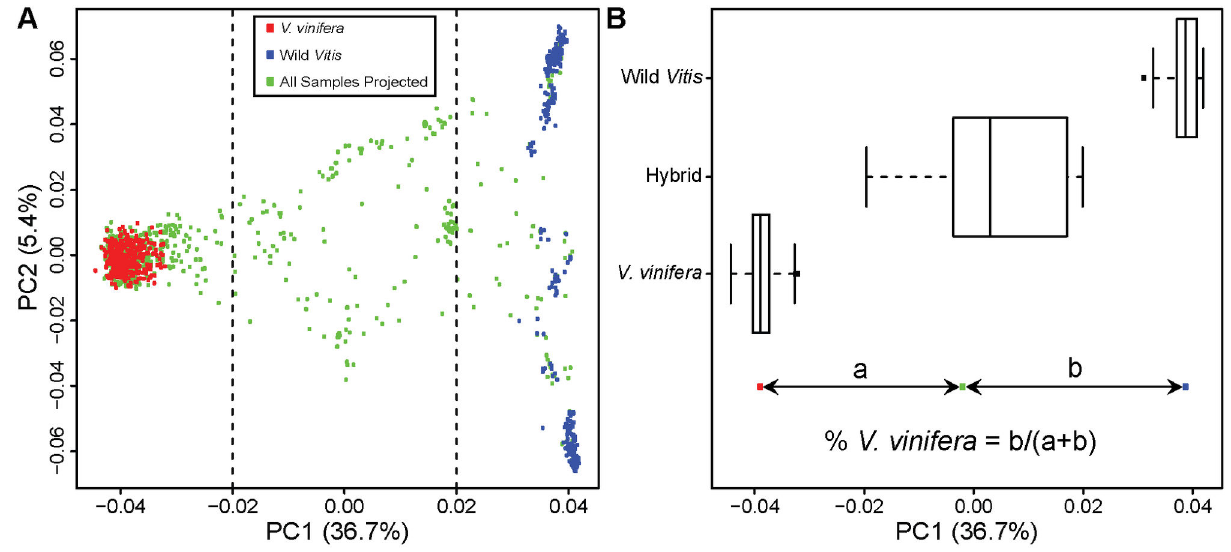
Figure 1. PCA based ancestry estimation. (A) PC axis 1 (PC1) and PC2 were calculated using 2959 SNPs from 333 V. vinifera and 333 wild Vitis samples. The proportion of the variance explained by each PC is shown in parentheses along each axis. Subsequently, 1599 samples, including various Vitis species and hybrids, were projected onto these axes (green dots). Samples lying between the dotted vertical lines were considered hybrids for the remaining analyses. (B) Boxplots show the range of PC1 values for the two ancestral populations ( V. vinifera and wild Vitis ) and the hybrids identified in (A). Boxes denote upper and lower quartiles and whiskers extend to 2.7 SD. Below the boxplots, an illustration of how ancestry proportions are calculated is provided (see Methods for